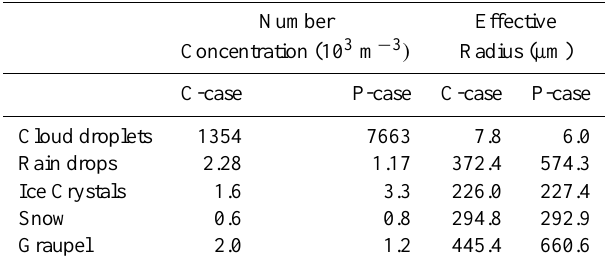
Table 1. Domain-averaged Properties of